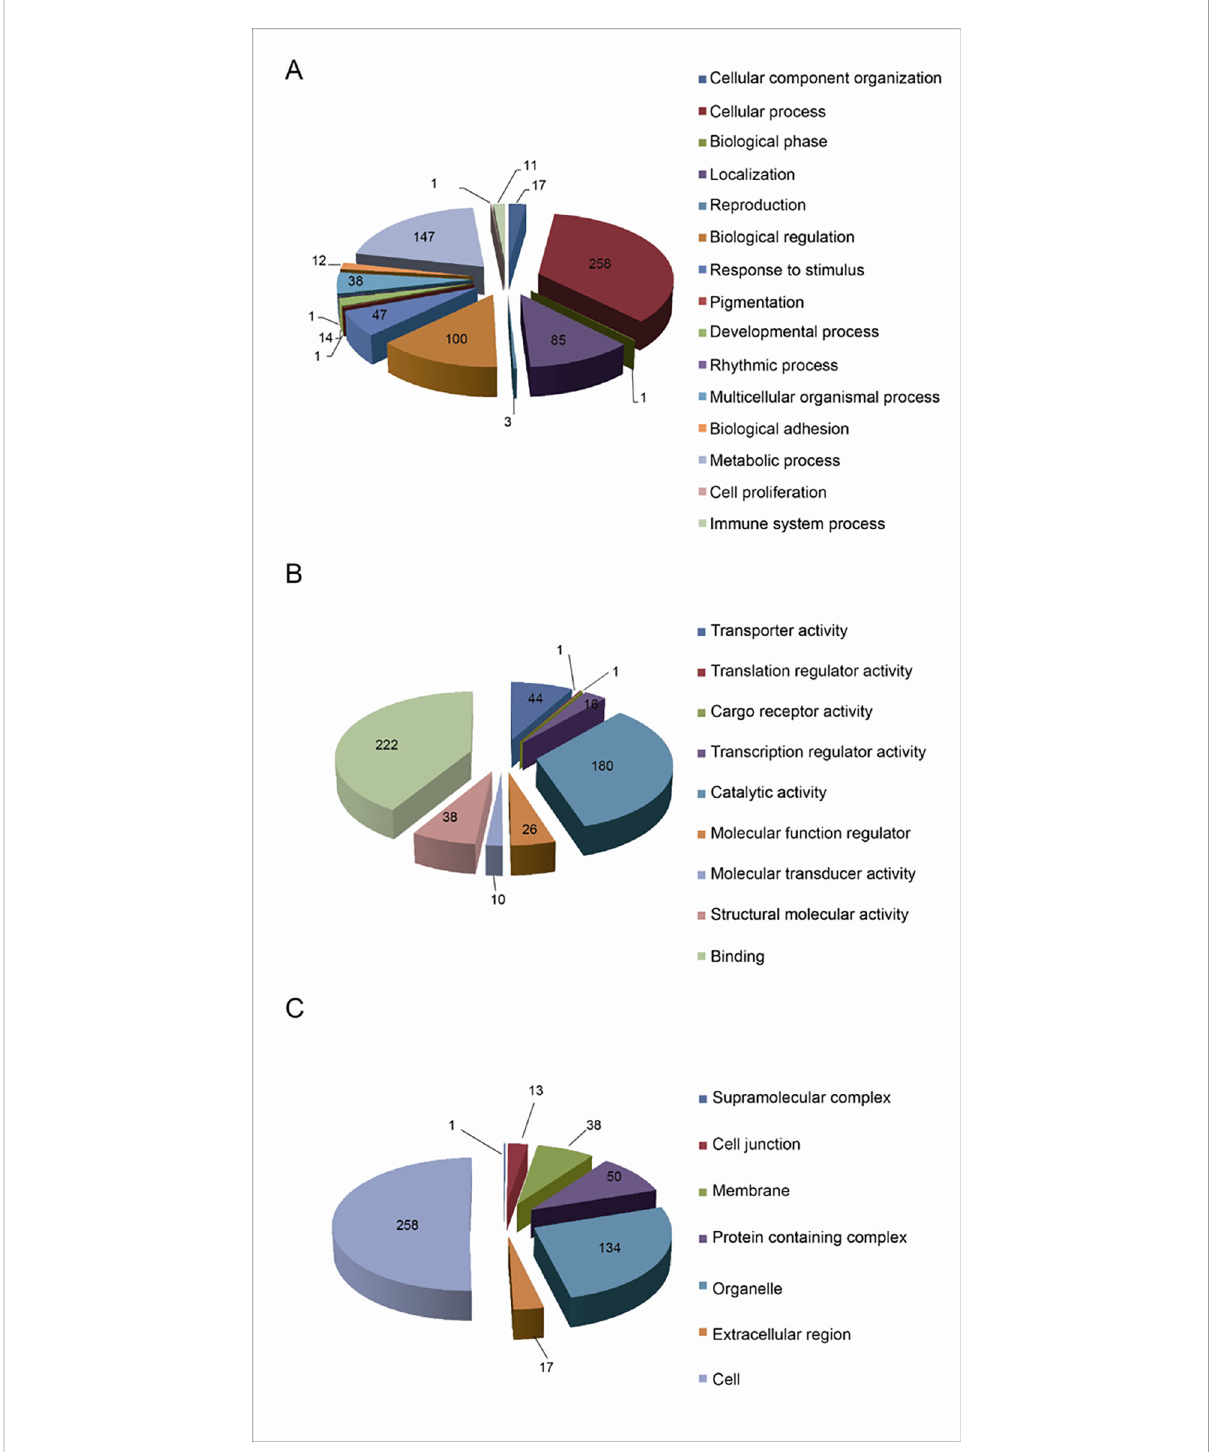
FIGURE 3 Functional characteristics of 627 Ups identi fi ed with GO enrichment analysis. (A) The BP pro fi le of UPs. (B) The MF pro fi le of UPs. (C) The CC pro fi le of